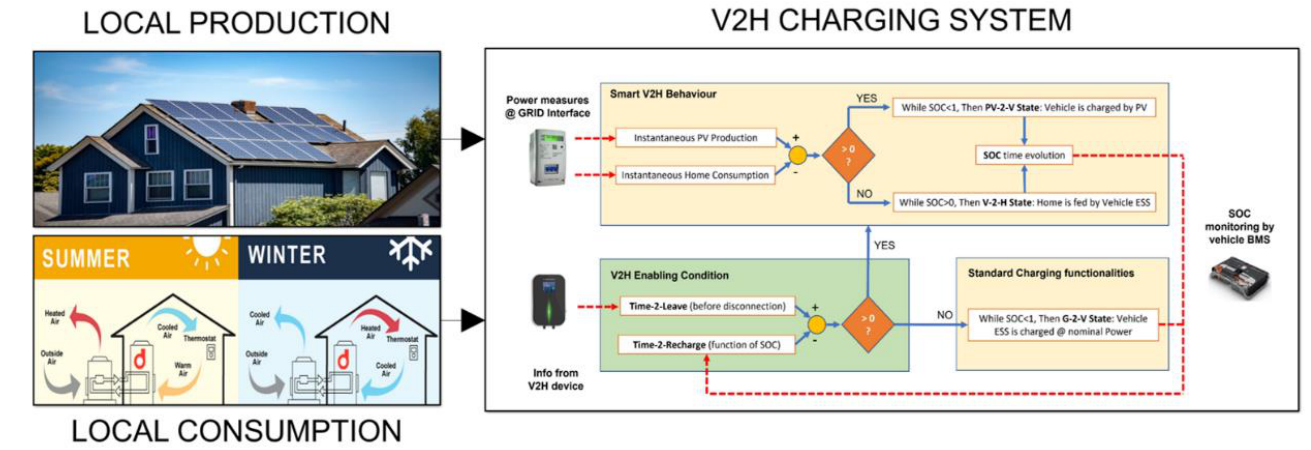
Figure 8. Main screen of the developed Matlab-Simulink simulation software.